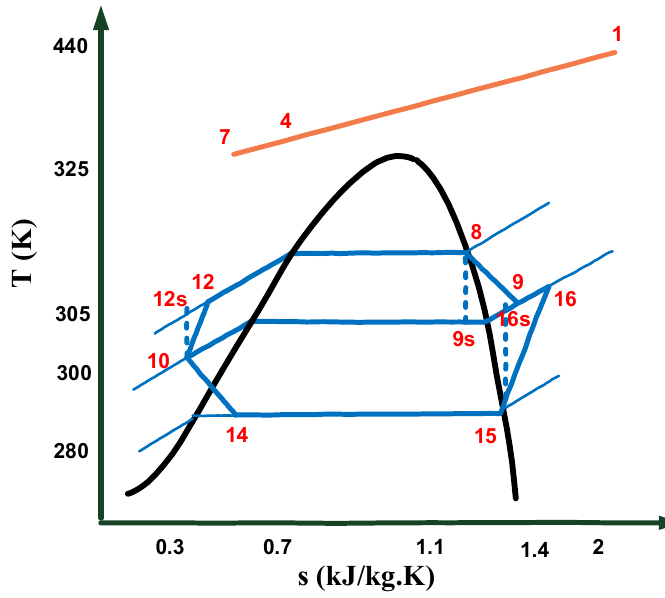
Figure 2. T–s diagram for the ORC working fluid.